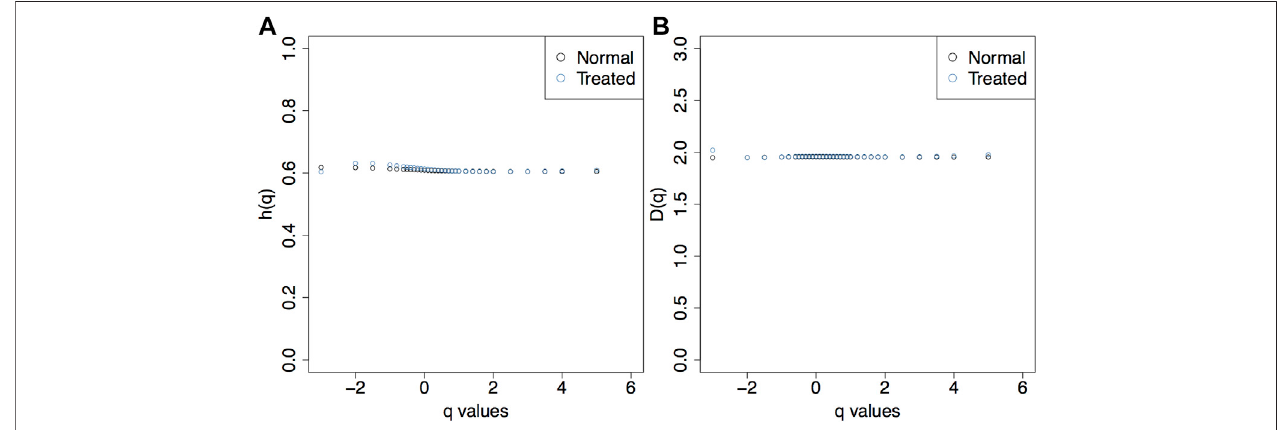
FIGURE 10 | The h ( q ) (A) and D ( q ) (B) plots show that the rescue method does not fundamentally alter the behavior of the statistics when applied to unsaturated